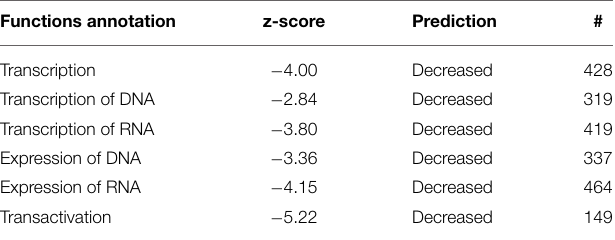
TABLE 3A | Subcategory functions for genes annotated to gene expression along with predictions for activation state. Functions annotation